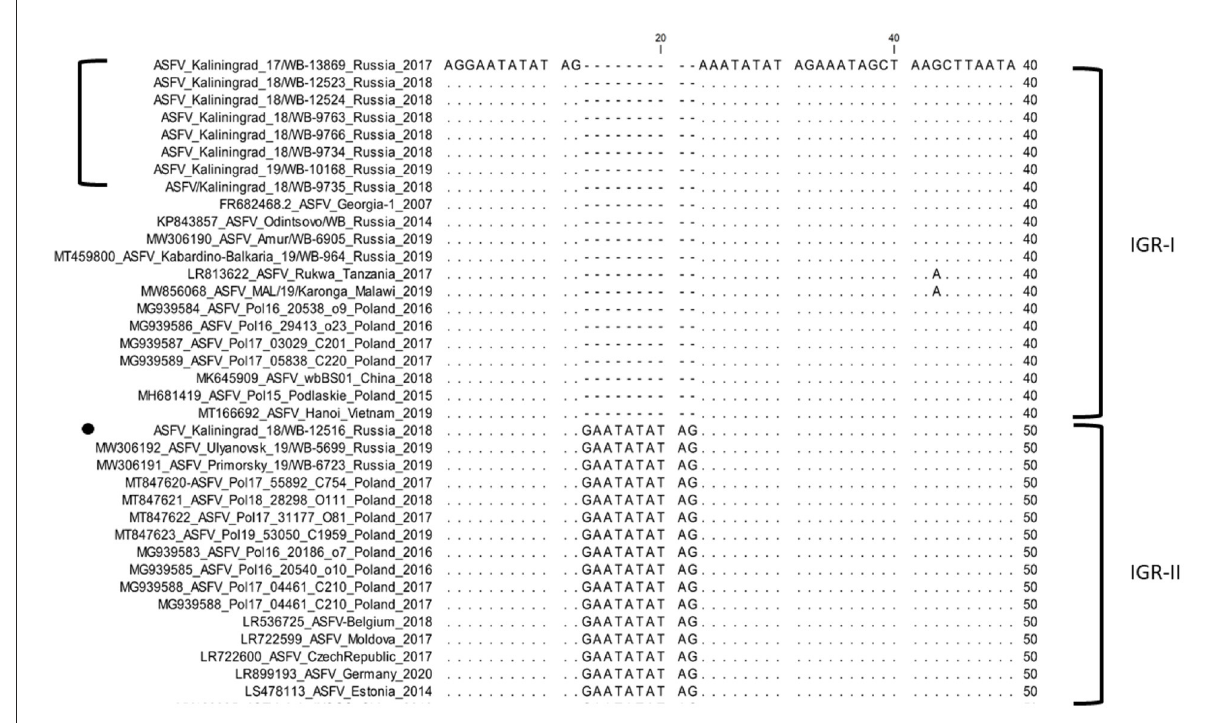
FIGURE3 Nucleotide sequence alignment of the intergenic region between I73R and I329L genes of ASFV strains belonging to either cluster IGR-I or cluster